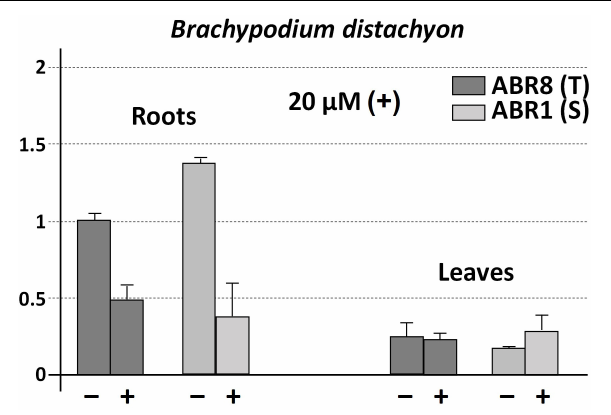
FIGURE 5 | Expression patterns (qRT-PCR) of BdCS4 at 24 h with 20 µ M AlK (SO4) 2 (+) and without AlK (SO4) 2 ( − ) treatments using root apices and leaf of ABR1 (sensitive line) and ABR8 (tolerant line) of B. distachyon . The expression level of 18S rRNA was used as a loading control. The change at each treatment is expressed as the relative difference in expression compared with the tolerant genotype diploid (ABR8) without exposure to Al ( − ). Error bars represent standard deviations (SDs). All data are the means of three independent biological and technical